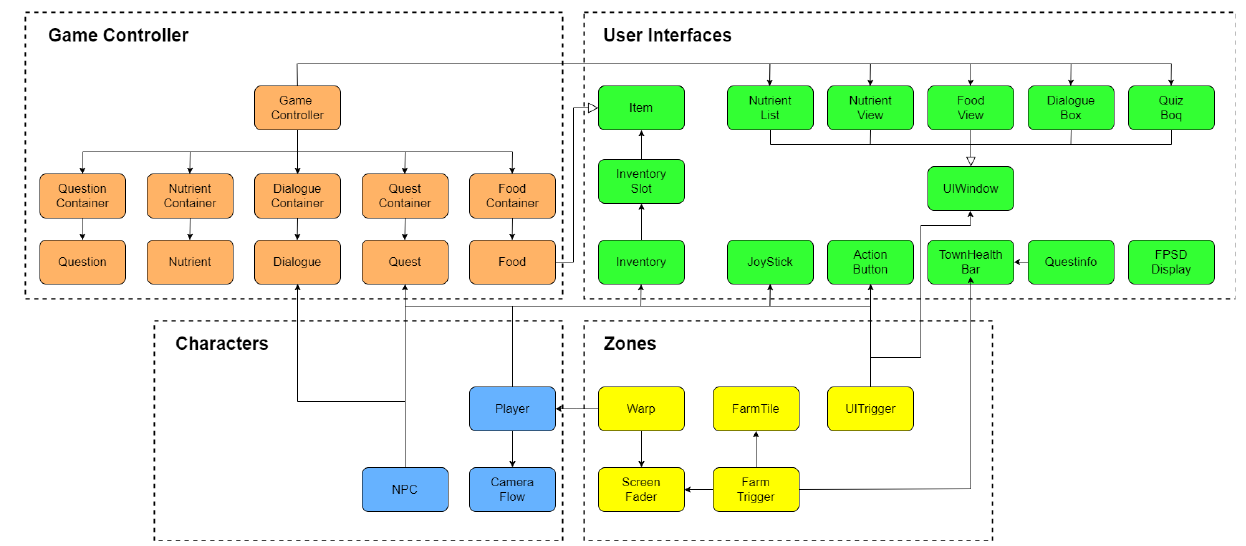
Figure 1. VitaVillage high-level class diagram.